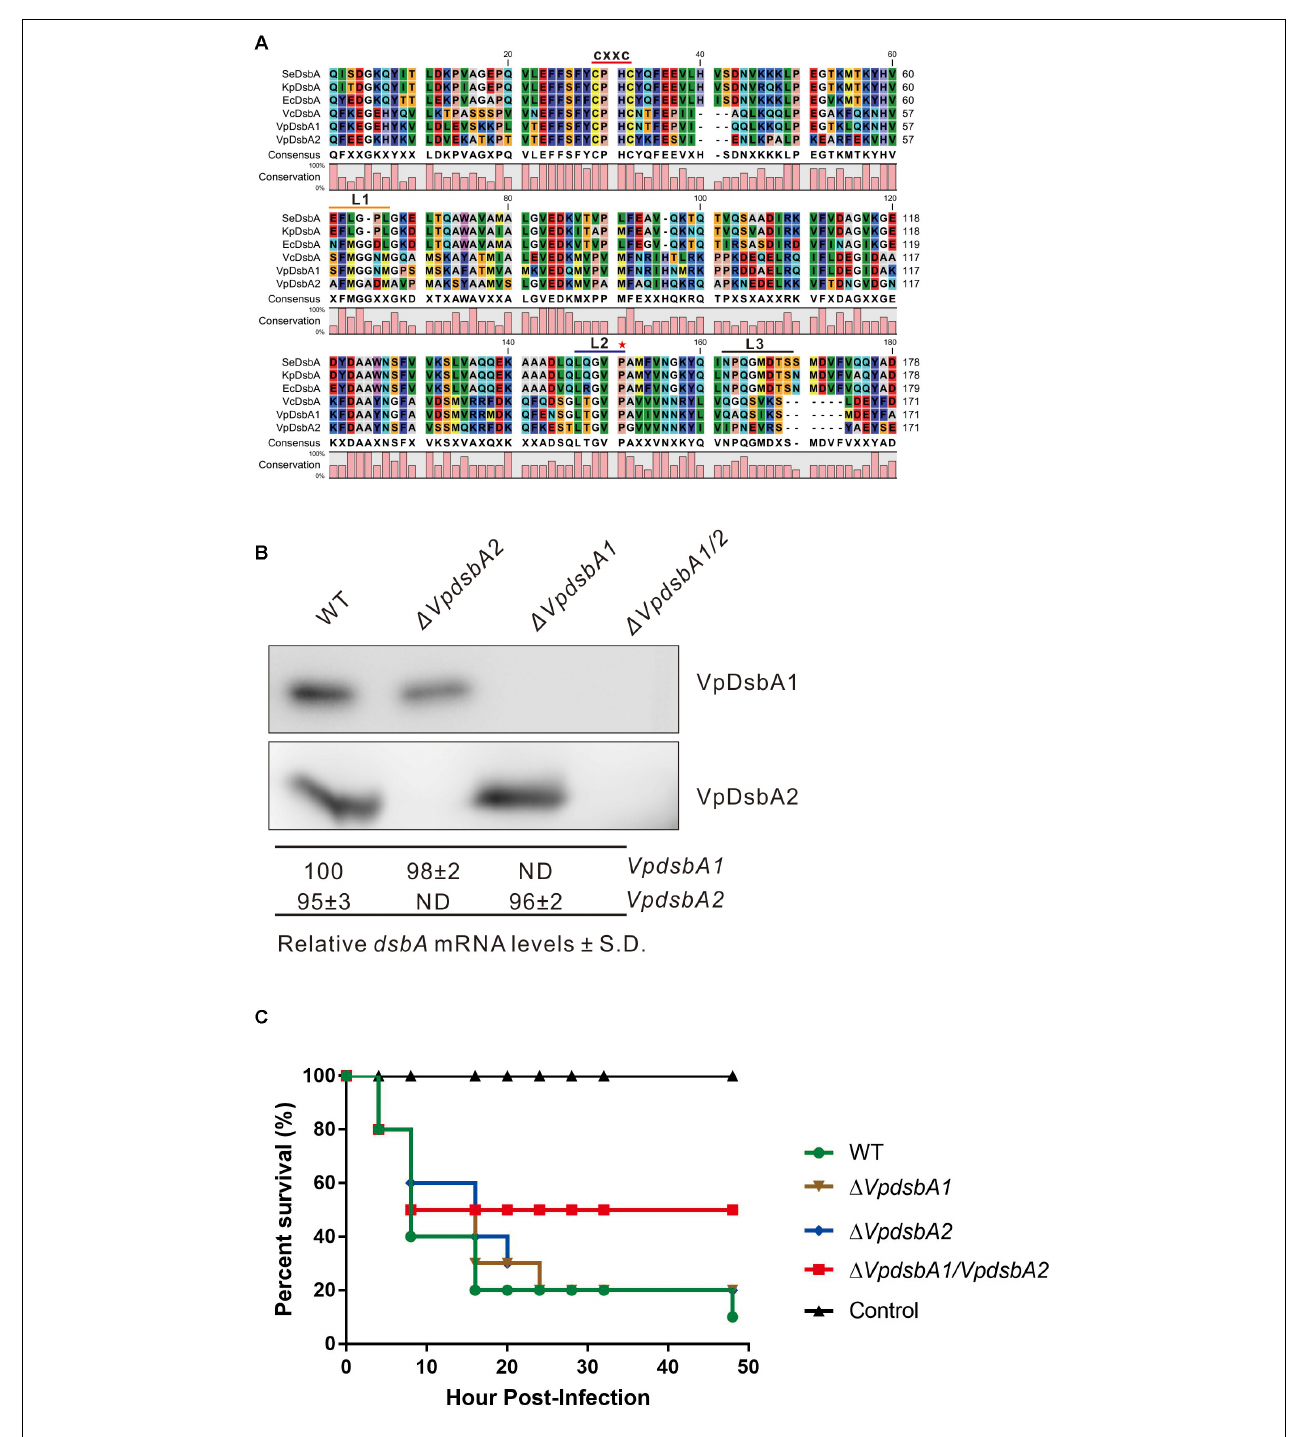
FIGURE 1 | VpDsbAs modulate V. parahaemolyticus virulence in zebrafish. (A) Amino acid alignment of VpDsbA1, VpDsbA2, VcDsbA, and EcDsbA. The red line indicates the conserved CXXC motif. Three loop sequences of L1, L2, and L3 are indicated as an orange, blue, and black line, respectively, and a red star indicates the predicted cis Pro. (B) Top , analysis of VpDsbA1 and VpDsbA2 expression level. V. parahaemolyticus WT, (cid:49) VpdsbA1 , (cid:49) VpdsbA2 , and (cid:49) VpdsbA1/2 were grown in LB-NaCl until OD 600 ≈ 0.8. Cell lysates (1 mg) were separated by SDS-PAGE and VpDsbA1 or VpDsbA2 was detected by the Western blot using antiserum specific for either VpDsbA1 or VpDsbA2. Blot shown is representative of at least three separate experiments. Bottom , analysis of VpdsbA1 and (cid:49) VpdsbA2 mRNA levels by qRT-PCR. RNA was purified from freshly prepared cultures grown in LB-NaCl. The % dsbA mRNA levels ± standard deviation (SD) were normalized to 16S RNA for each strain and relative to WT (set to 100%). ND, none detected. (C) Survival curves (Kaplan–Meier) of zebrafish following intraperitoneal challenges